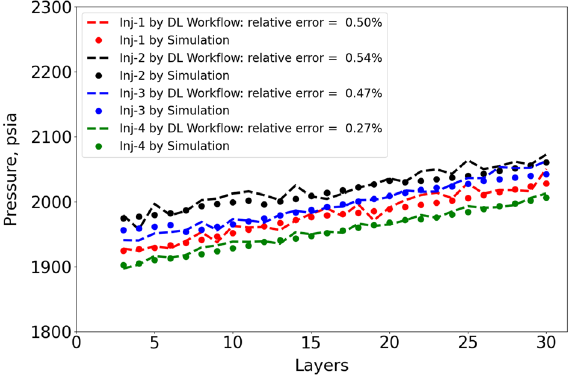
Figure 12. Pressure in injection well grid cells at year 10 versus storage